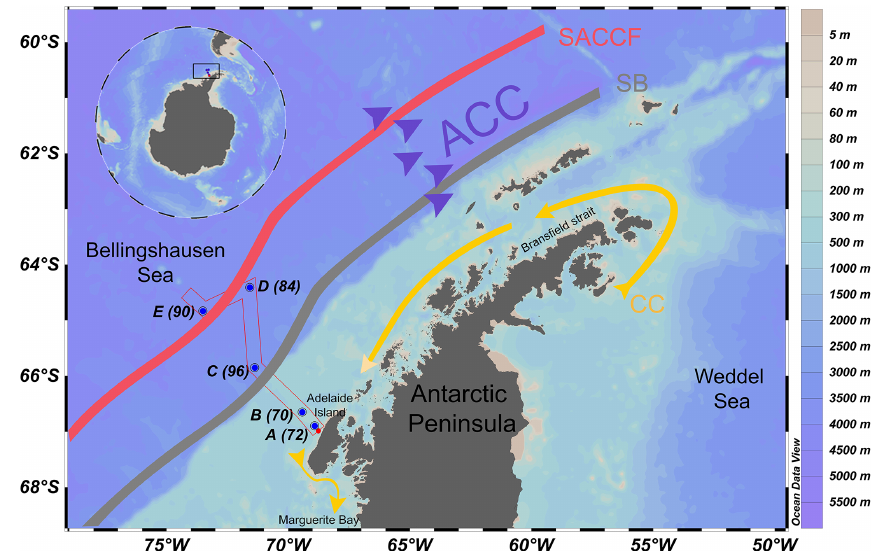
Figure 1. Map of the sampling sites along our study transect near the western Antarctic Peninsula. The stations are indicated by blue dots and station numbers. The Antarctic Circumpolar Current (ACC) is indicated by purple arrows. The coastal current (CC) is indicated by a yellow arrow. The southern boundary (SB) of the ACC front is indicated by the grey line. The southern ACC front (SACCF) is indicated by the red line. See Fig. 6 in Arrigo et al. (2017) for details on the ACC flow